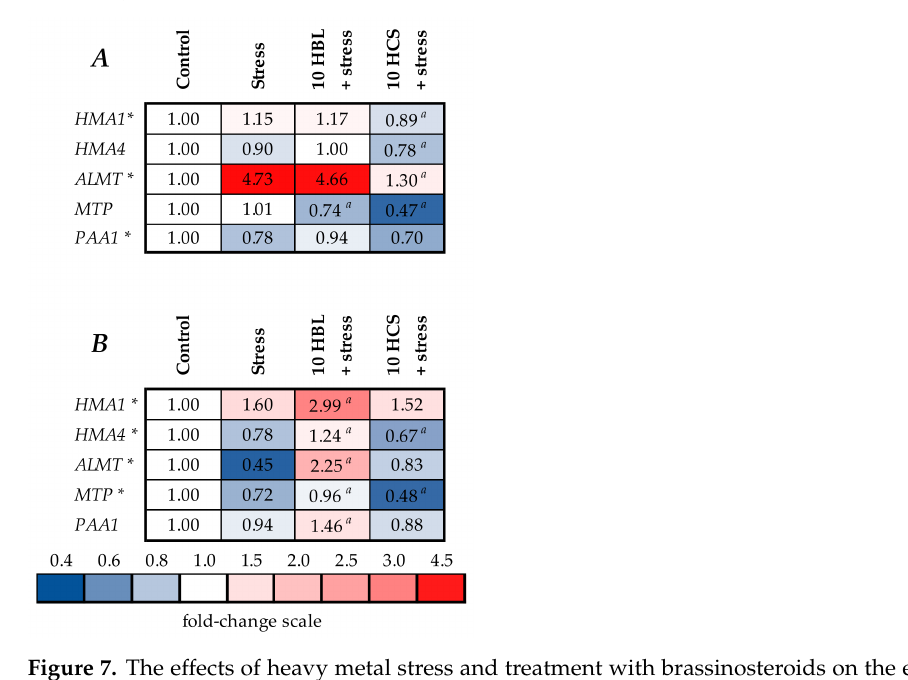
Figure 7. The effects of heavy metal stress and treatment with brassinosteroids on the expression of genes involved in metal detoxification in roots ( A ) and shoots ( B ) of barley plants. The value in the control plants was taken as 1.0, the relative decrease is indicated in blue, the relative increase is indicated in red. Asterisks (*) indicate significant differences from the control variant, and the a letter indicates significant differences from the polymetallic stress-treated variant ( p <